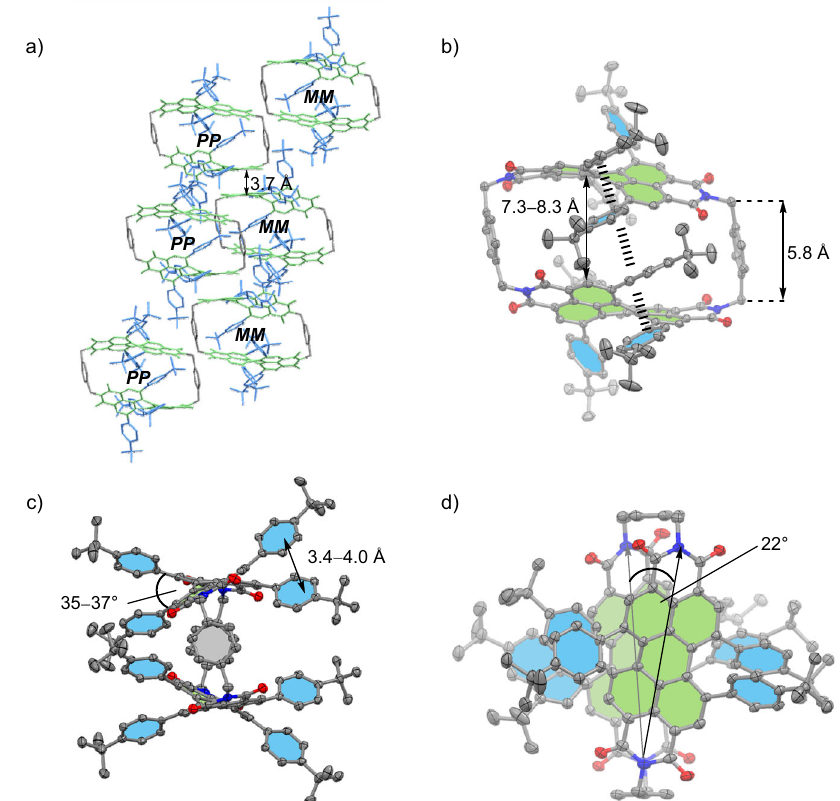
Fig. 2 | Single crystal X-ray analysis of rac- 1. Molecular structure and packing of cyclophane rac - 1 in the solid state according to single crystal X-ray analysis. a Packing arrangementinthe crystalisshowninthesideview. b Side, ( c )frontand ( d ) top view of the molecular structure of 1- PP . Hydrogen atoms and solvent